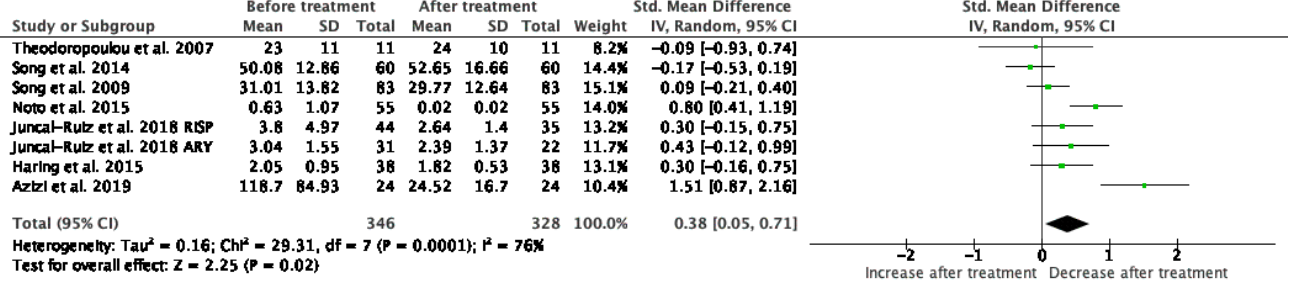
Figure 6. Meta-analysis of TNF- α .